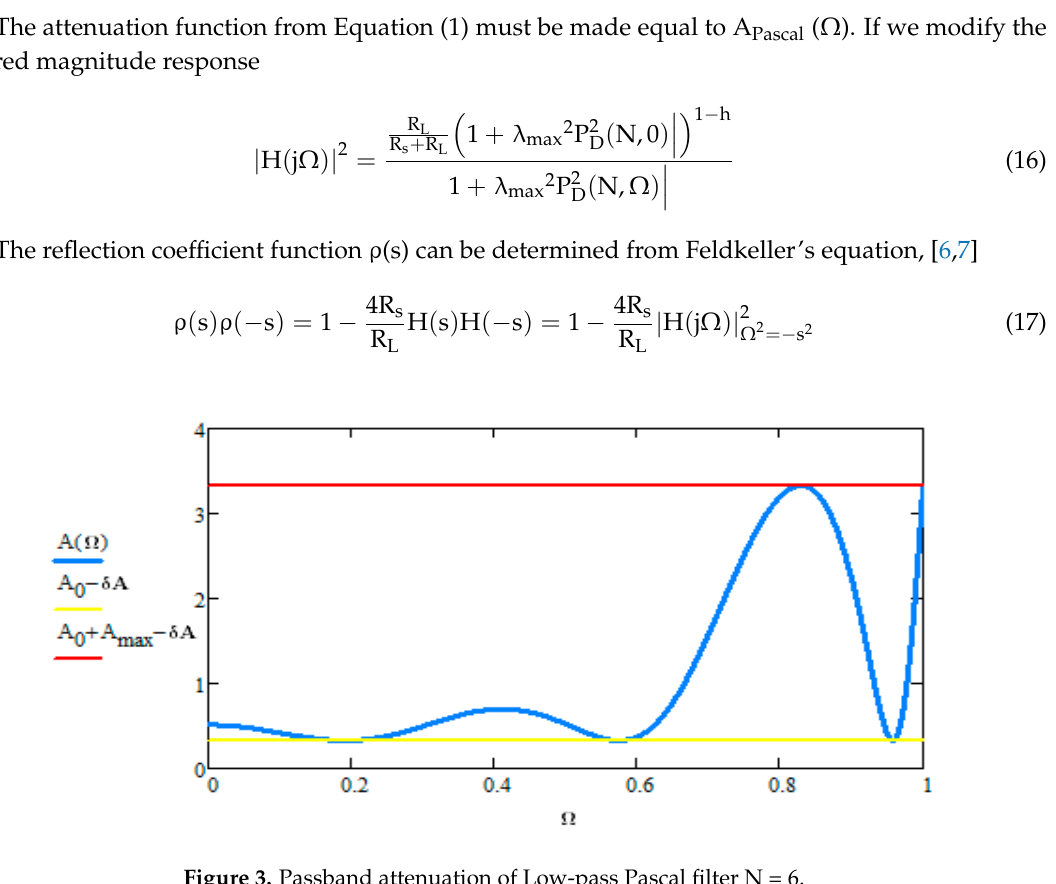
Figure 3. Passband attenuation of Low-pass Pascal filter N = 6.